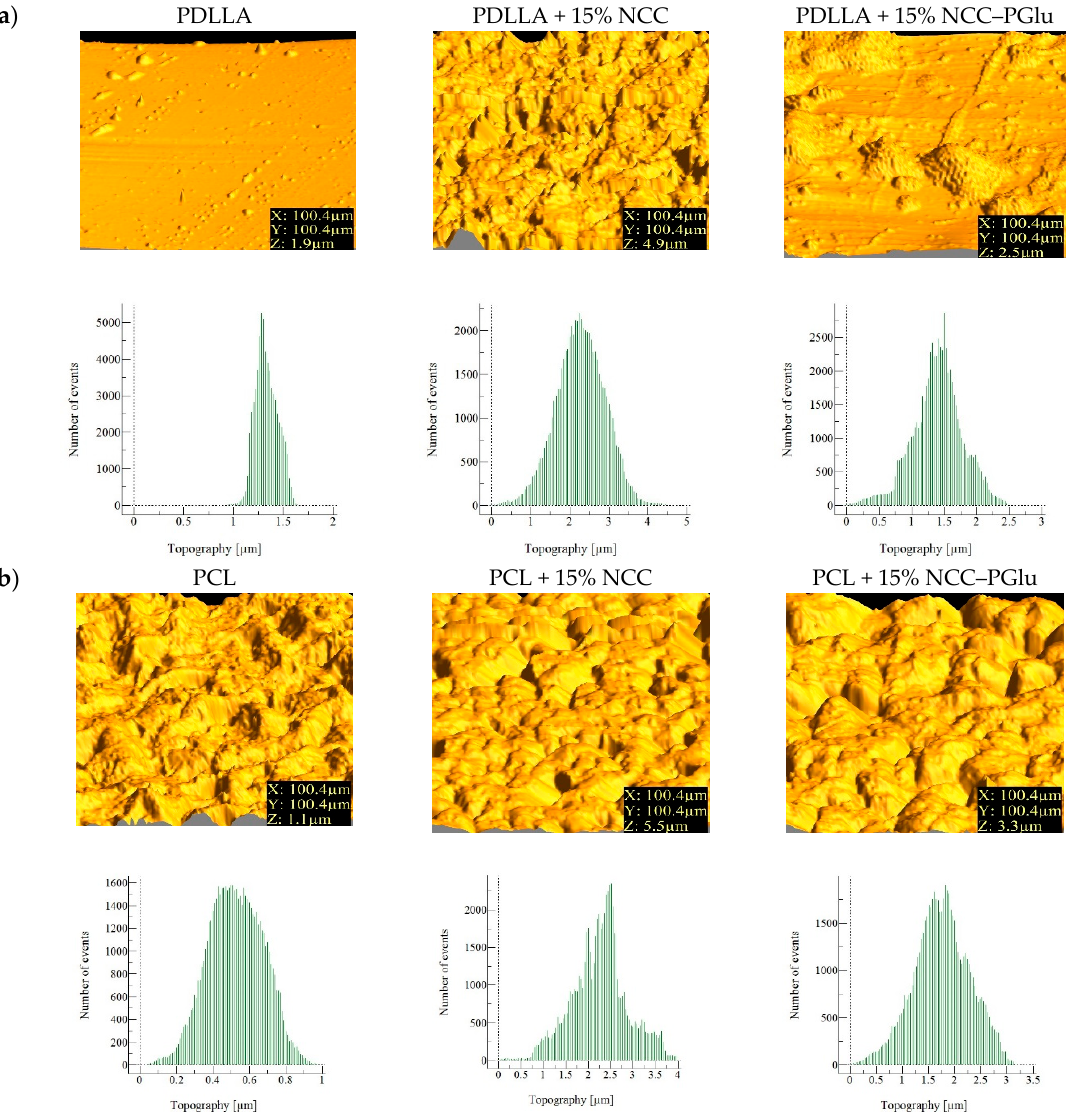
Figure 5. Atomic force microscopy (AFM) images and roughness profile of the images for PDLLA-based ( a ) and PCL-based ( b ) pure and composite films.